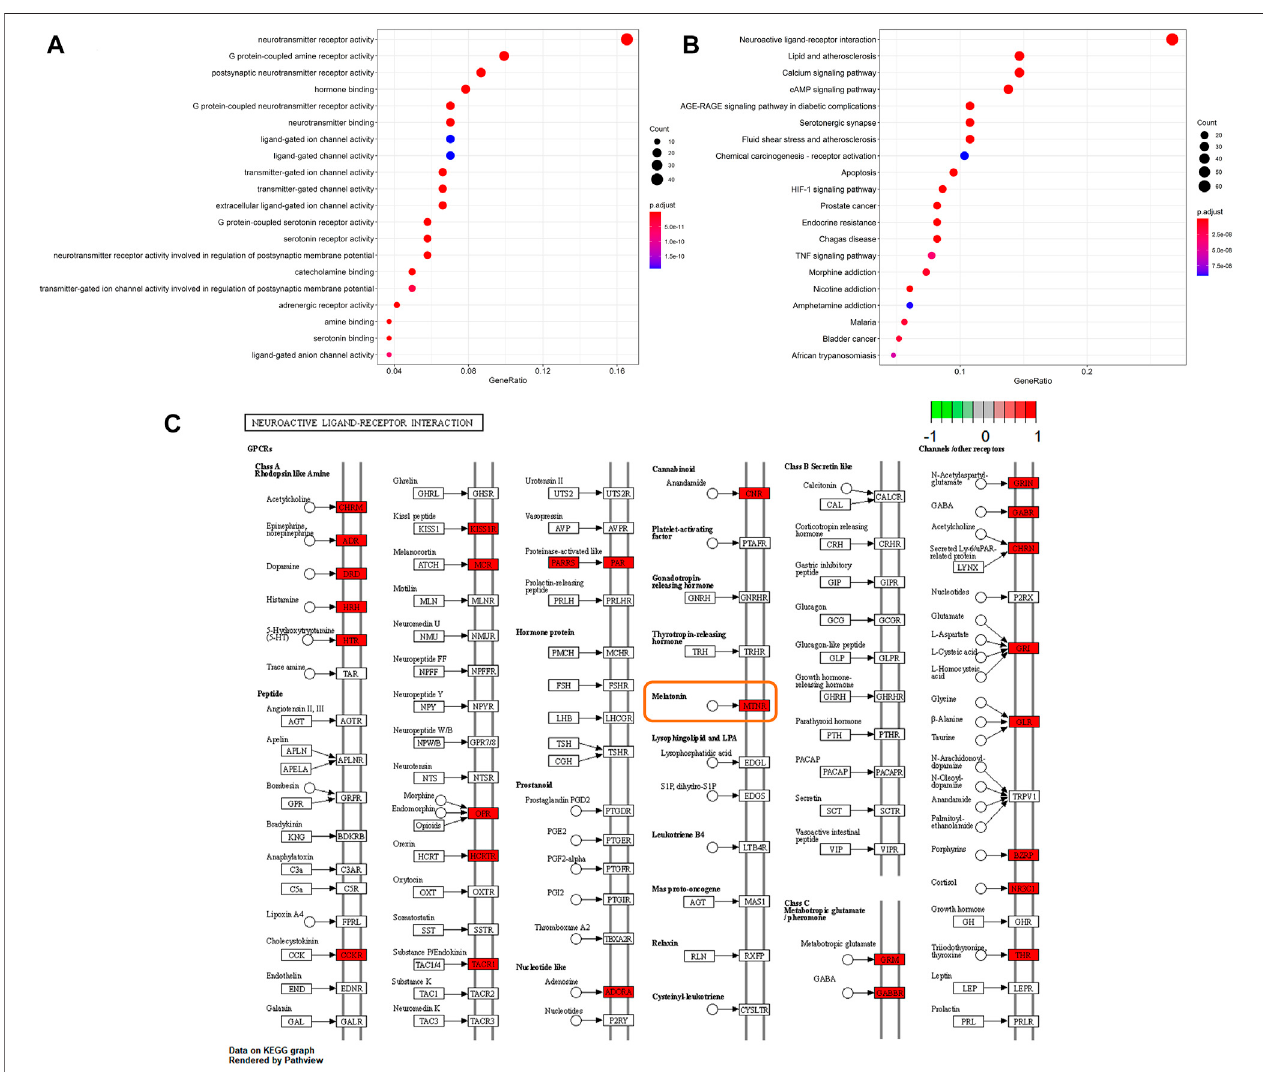
FIGURE4| Statisticsoffunctionaland pathwayenrichment.Thex-axisrepresentstherationumber ofgenes,andthey-axis showsthepathway terms. Thesizeof thecirclerepresentsgenecount.Differentcolorofcirclesrepresentsdifferentadjusted p -value. (A) Scatterplotoftop20enrichedGOfunctionalanalysis. (B) Scatterplot of top 20 enriched KEGG pathways. (C) Signal pathways in neuroactive ligand-receptor interaction based on the KEGG functional analysis.